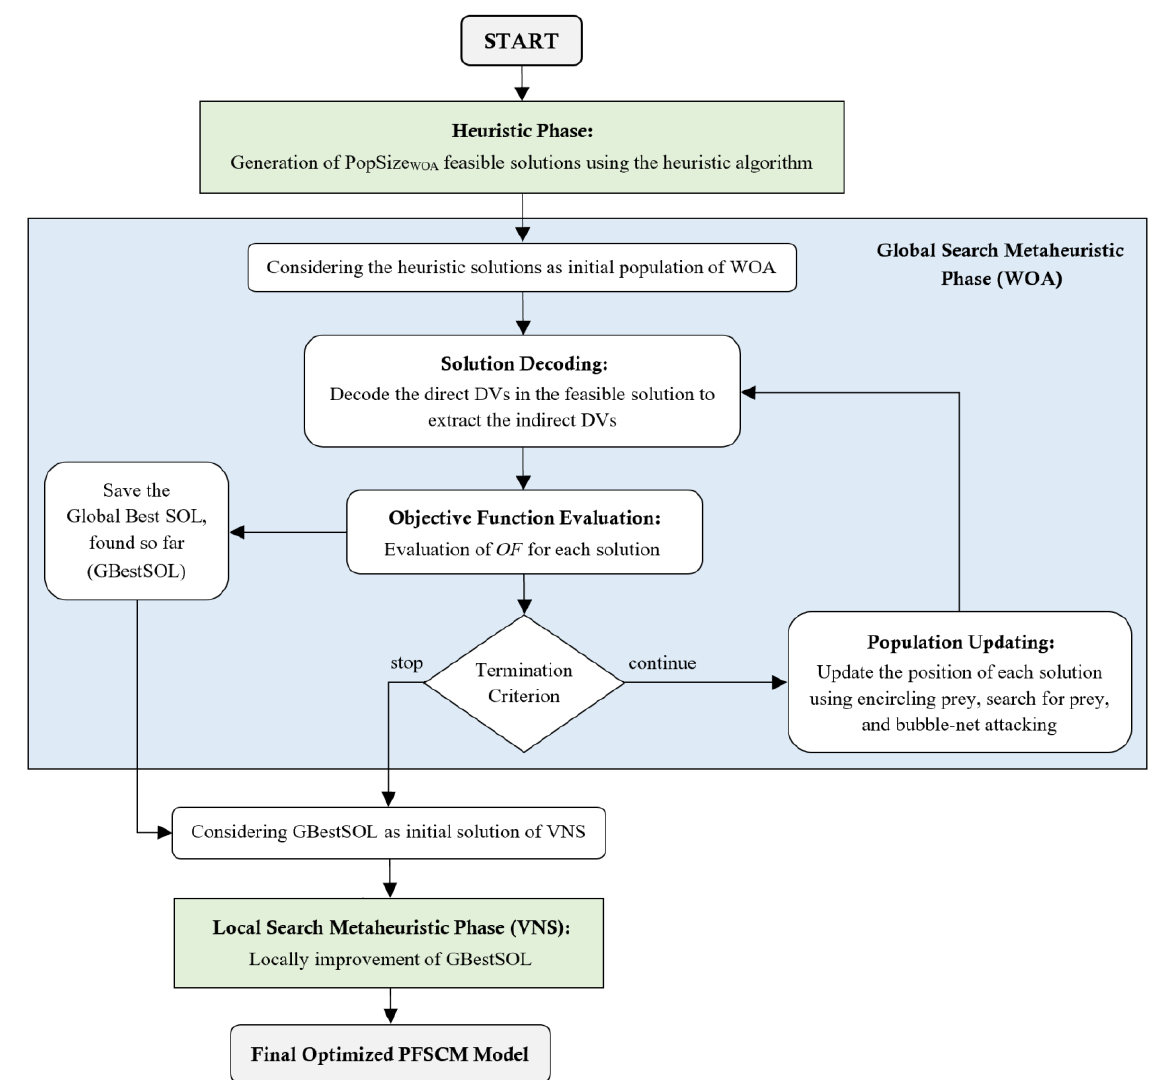
Figure 2. Overall flowchart of the proposed H-WOA-VNS algorithm.